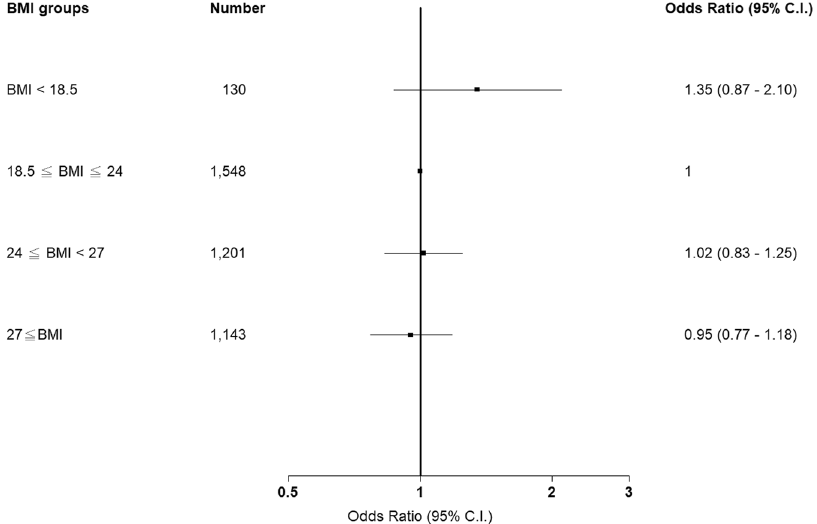
Figure 2. Association between body mass index and the risk of estimated glomerular filtration rate progression among patients with chronic kidney disease stages 1–5.